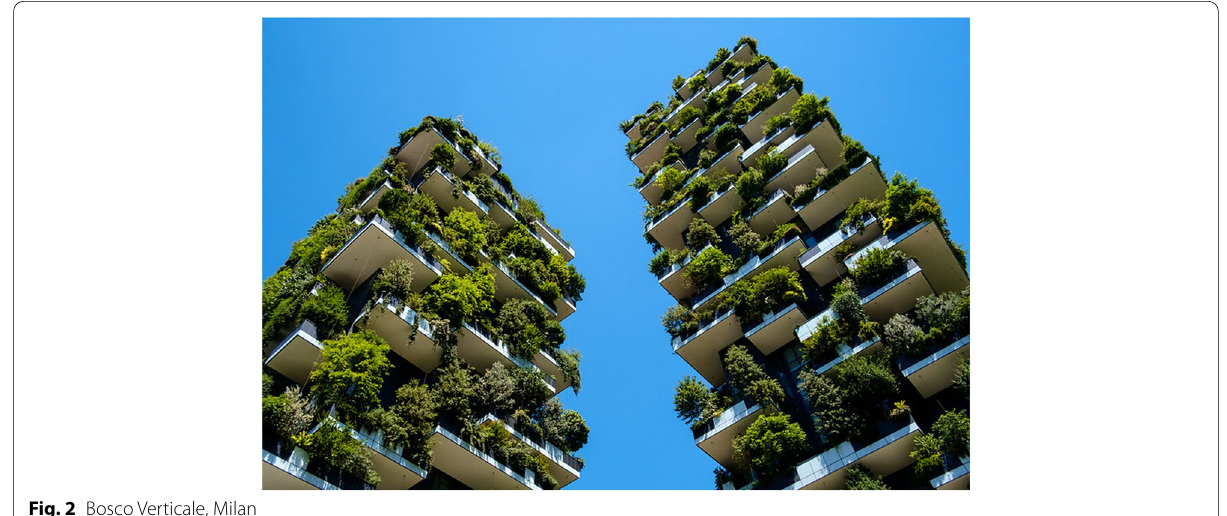
Fig. 2 Bosco Verticale, Milan